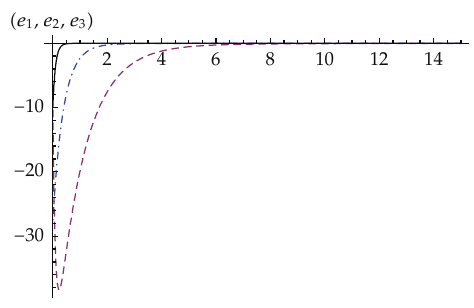
Figure 15: Synchronization